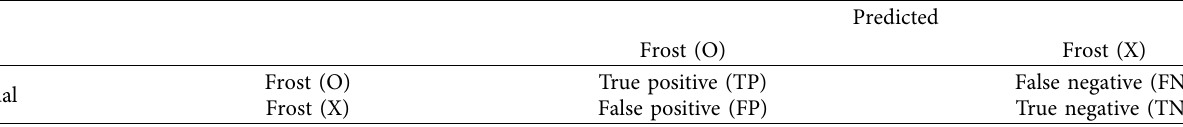
Table 4: Confusion